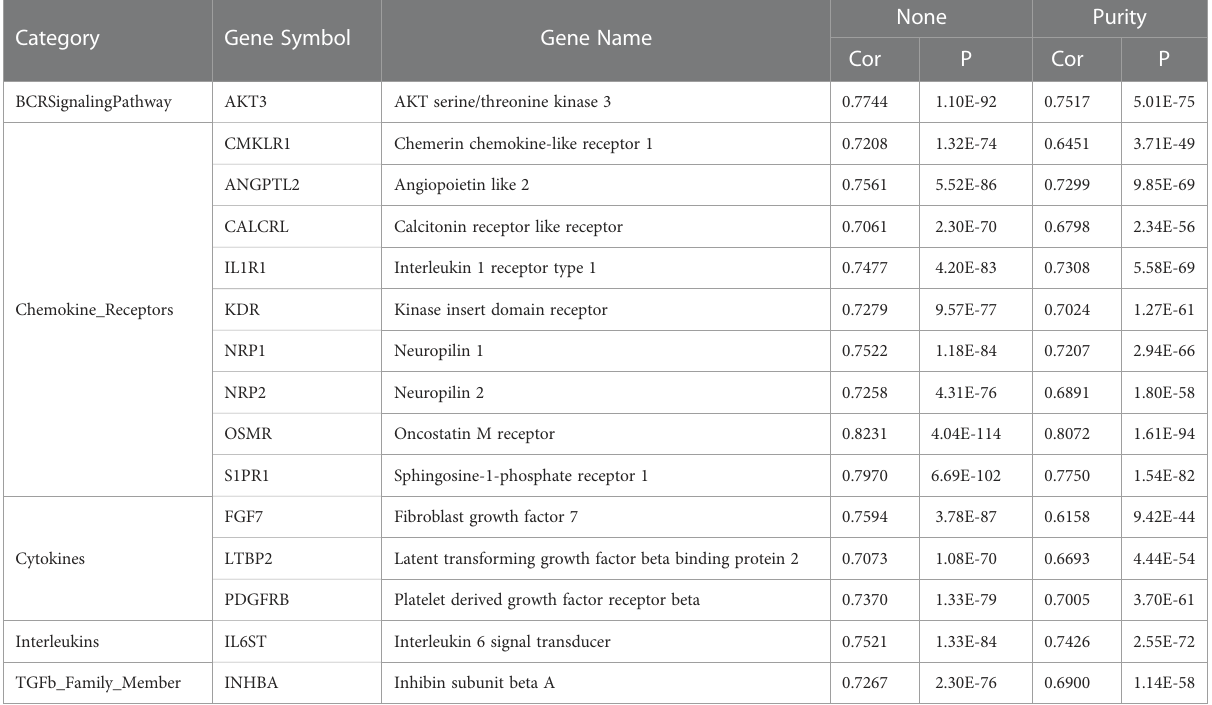
TABLE 4 Correlation analysis between ITG b 3 and immune-related genes (Cor > 0.7).